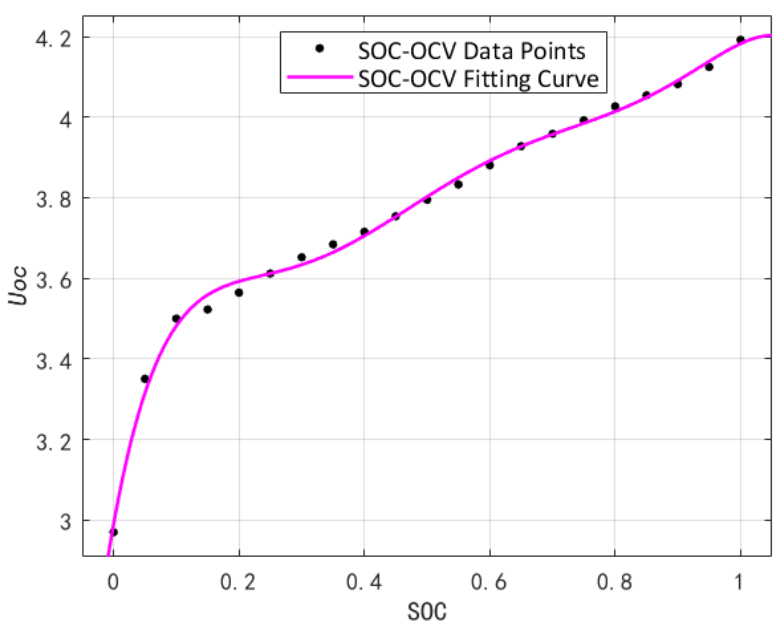
Figure 2. Fit SOC–OCV curve.